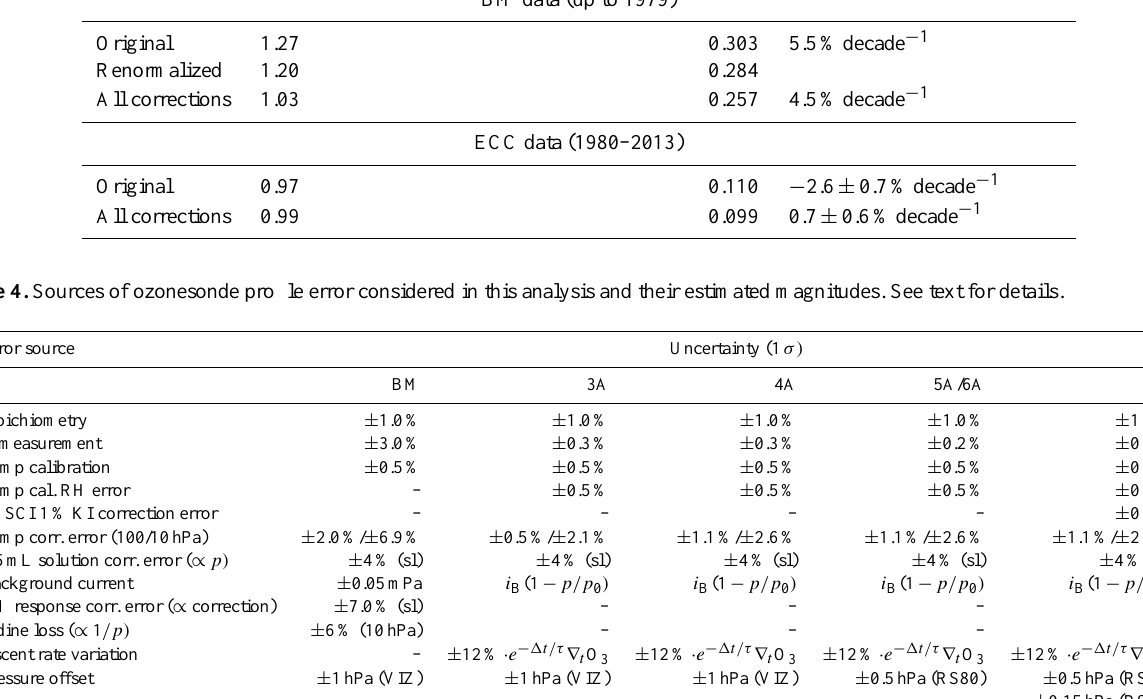
Table 3. Cumulative effects of corrections to ozonesonde data for the record at Edmonton (Stony Plain), as indicated by changes in the comparison of the integrated profile to a coincident spectrophotometric total ozone measurement.